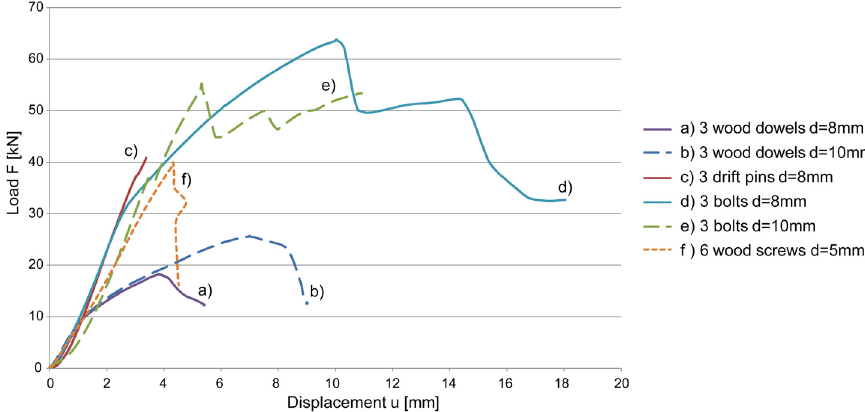
Figure 10: Load displacement diagrams of the investigated fasteners